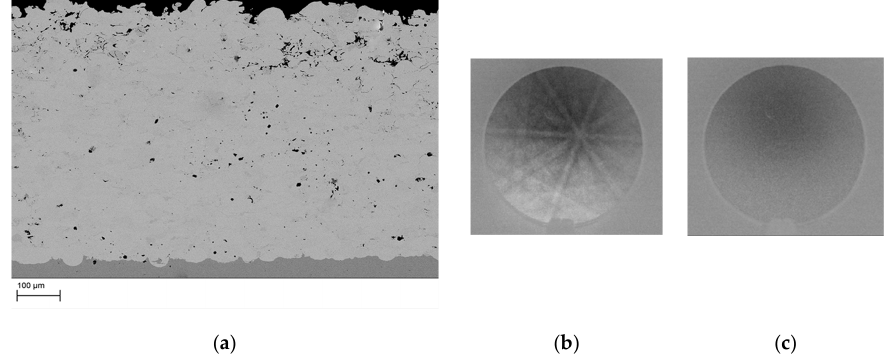
Figure 4. Results of EBSD analyses on a CGS coating in the as-sprayed condition: ( a ) cross-section of the sample as observed by SEM; ( b ) Kikuchi lines in the crystalline substrate, 1; ( c ) absence of Kikuchi lines in the amorphous coating, 2.